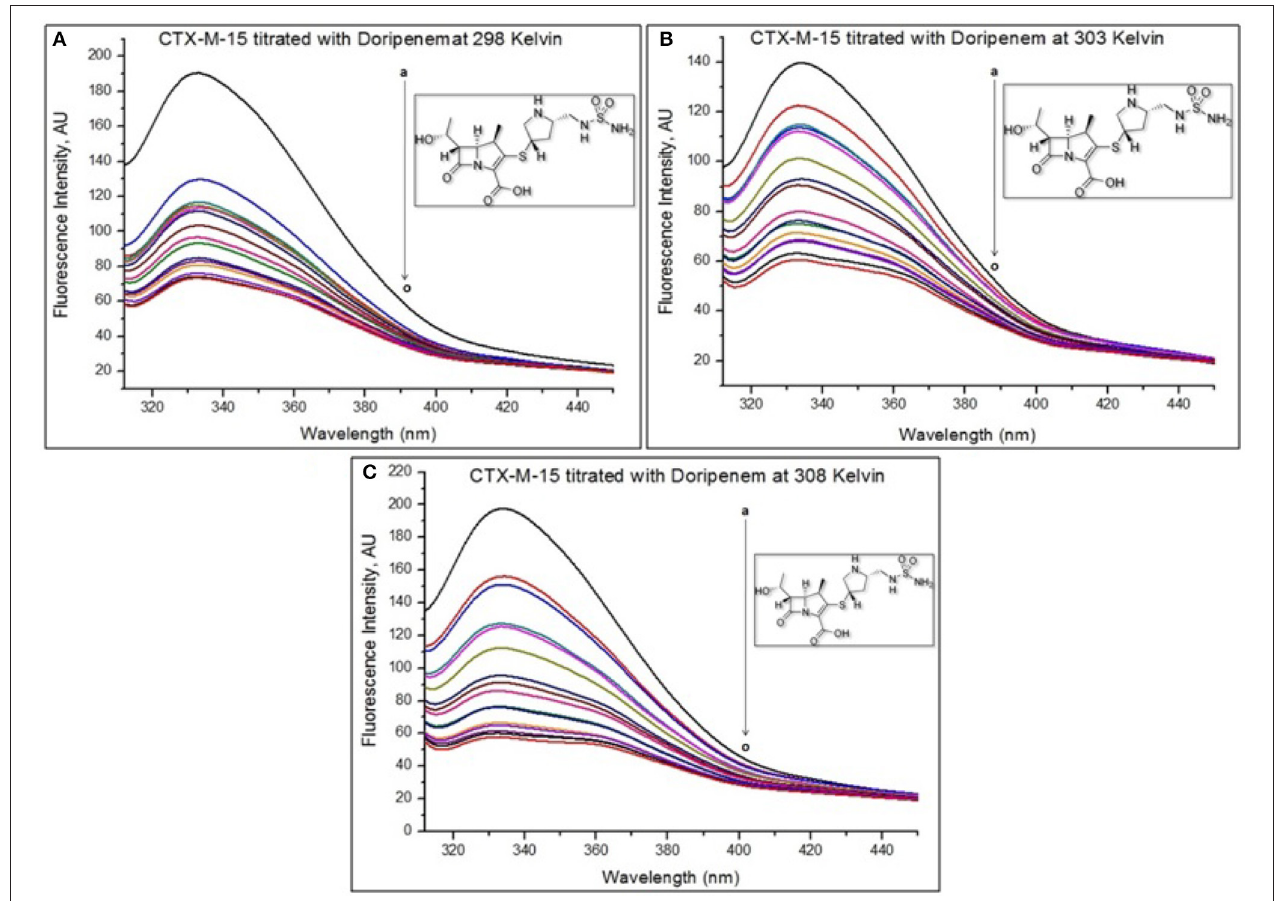
FIGURE 2 | The intrinsic fluorescence of the protein was measured at 298 K (A) , 303 K (B) , and 308 K (C) upon excitation at 295 nm in 50 mM sodium phosphate buffer of pH 7.4. Figure shows doripenem-induced fluorescence quenching of CTX-M-15. The concentration of CTX-M-15 taken was 2 µ M, and the concentration of doripenem was varied from 0 to 30 µ M (a–o) in a successive increment of 2 µ M Inset shows the structure of doripenem.